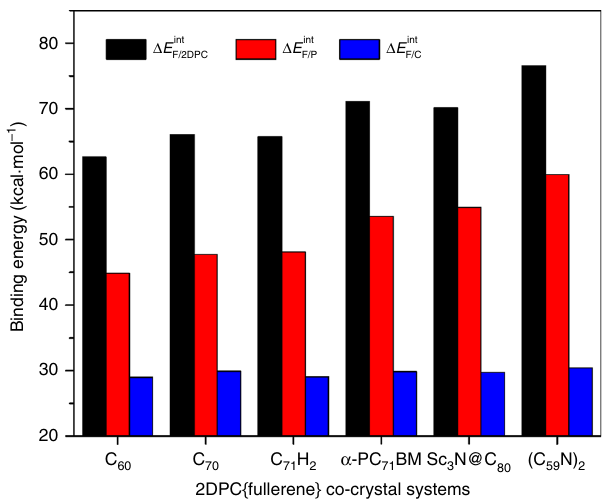
Fig. 6 The total interaction energies and partial interaction energies for six representative co-crystals. All values in the fi gure are absolute values. Δ E int Δ E int Δ E int F/2DPC (black columns), F/P (red columns), and F/C (blue columns) represent the interaction energies between fullerene (F) and both hosts (2DPC), fullerene (F) and pyrryl groups (P), and fullerene (F) and corannulene part (C),